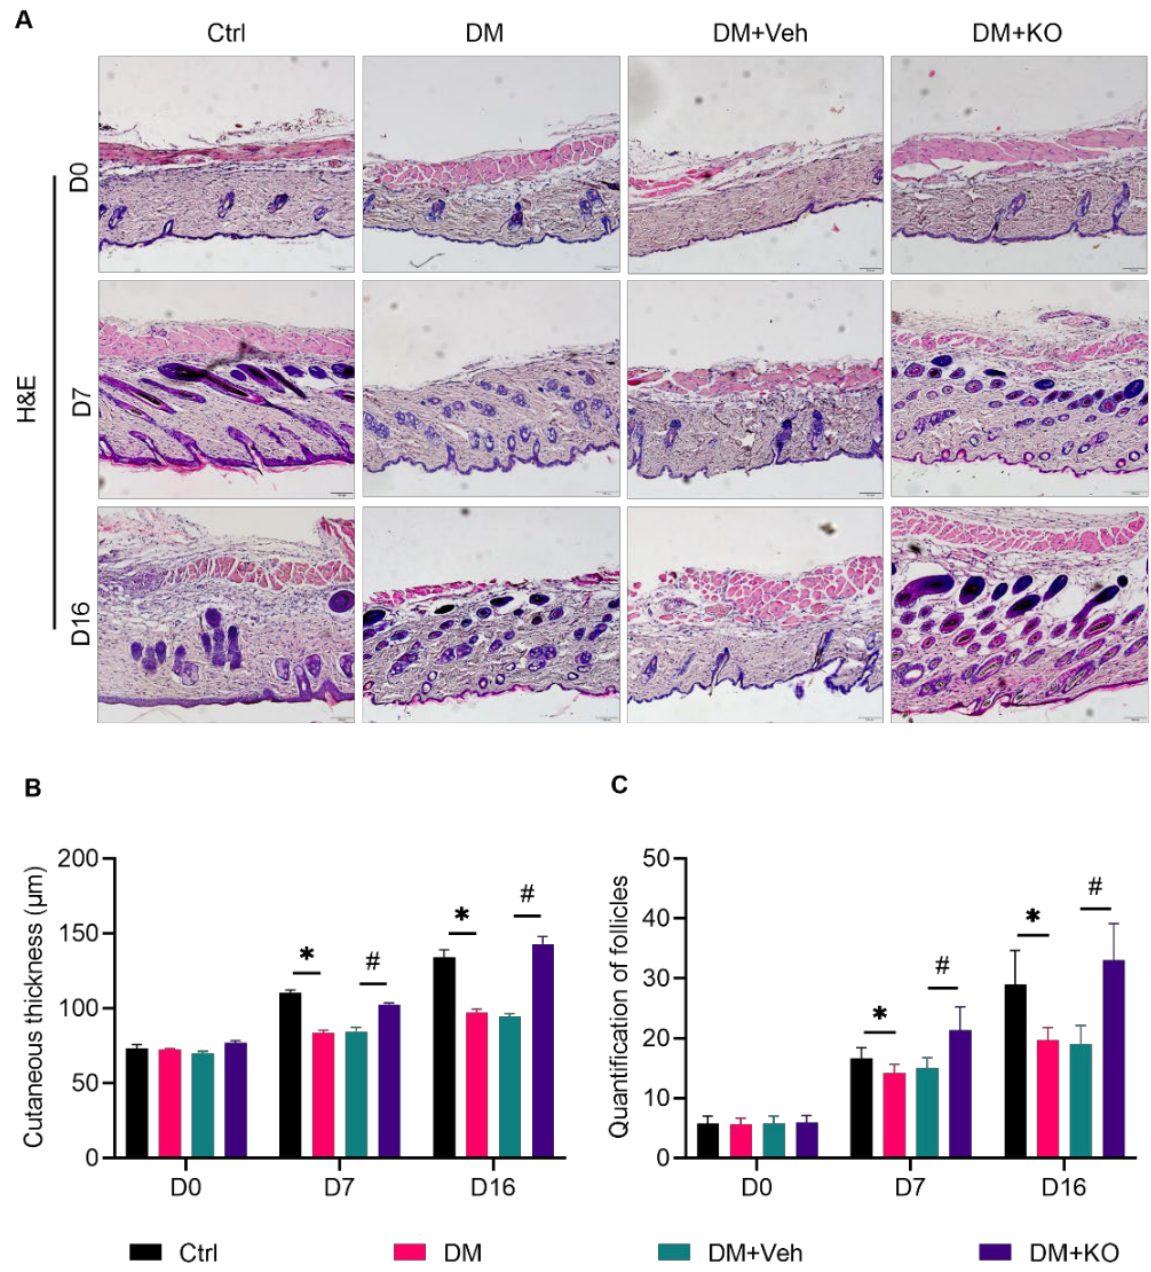
Figure 2. KO accelerated wound healing in the diabetic mice. ( A ) H&E staining was performed to assess ( B ) the cutaneous thickness and ( C ) follicle number of the wounds. The data were summarized as means ± SD. *, p < 0.05 vs. Ctrl; #, p < 0.05 vs. DM. Abbreviations are the same as in Figure 1. 3.3. KO Alleviated the TNF- α -Induced Macrophage Inflammation M1 polarization of macrophages is a major cause for excessive inflammation during diabetic wound healing [18]. The TNF- α level is increased in diabetic wounds, provoking macrophage M1 polarization [19]. In RAW264.7 cells, KO reduced the expression of the TNF- α -induced expression of M1 markers such as Il-1 β mRNA, the p -P65 to P65 ratio, and Vcam1 mRNA and protein (Figure 4A–D), and reversed the TNF- α -prohibited expression of Il-10 and Tgf- β 1 as markers for M2 polarization (Figure